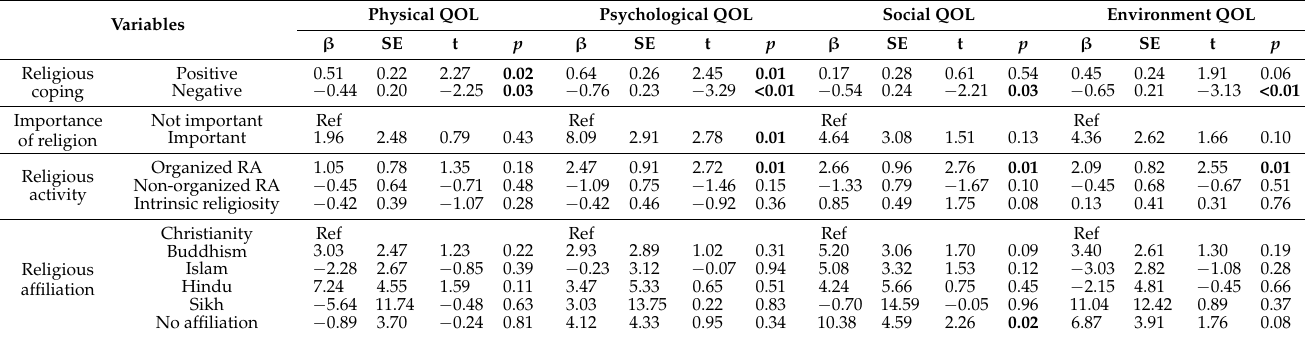
Table 4. Multiple linear regression model of religiosity and religious coping on QOL